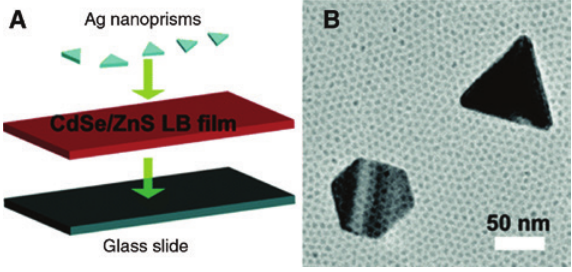
Figure 11: Layer-by-layer deposition of CdSe/ZnS QDs, PMMA spacer, and Ag nanoprisms. (A) Schematic showing the deposition of CdSe-ZnS QDs (red